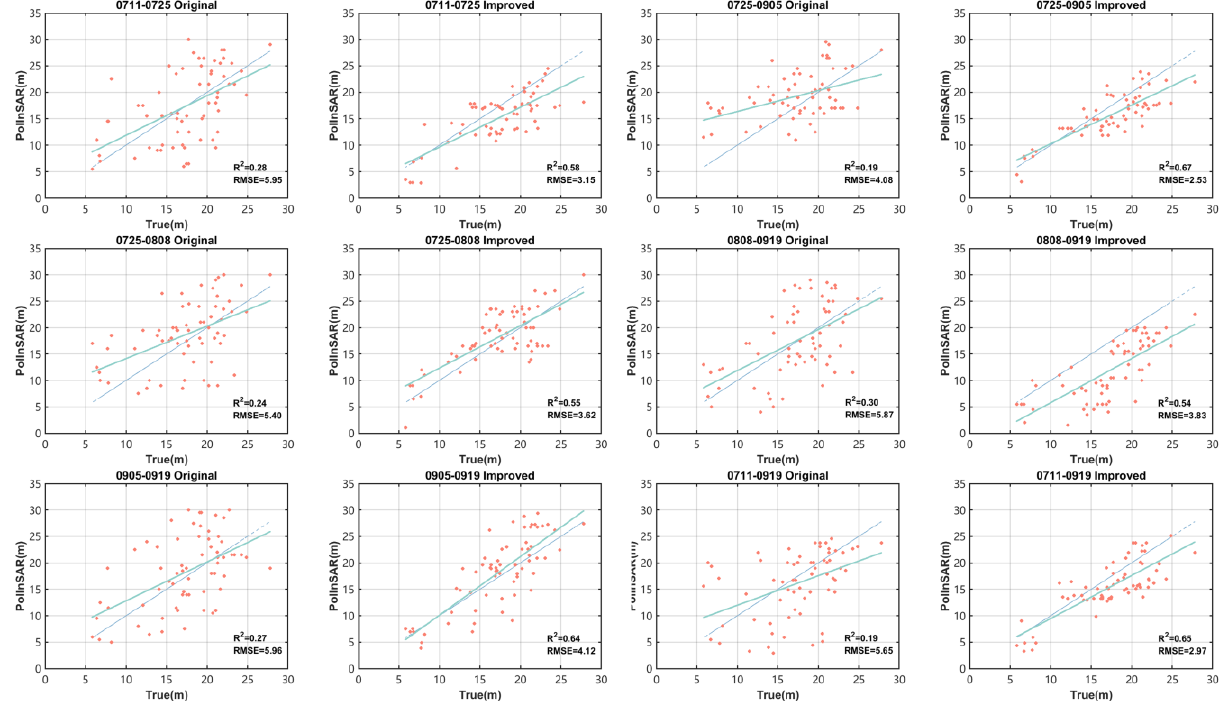
Figure 6. Fitting scatterplot of the inverse tree height in relation to the measured height for the original model and the improved model. The 1:1 line is in blue and the fitted curve is in green. The horizontal axis (True) is the measured tree height, the vertical axis (PolInSAR) is the model fitting result, R 2 and RMSE are the coefficient of determination and root mean square error, respectively.